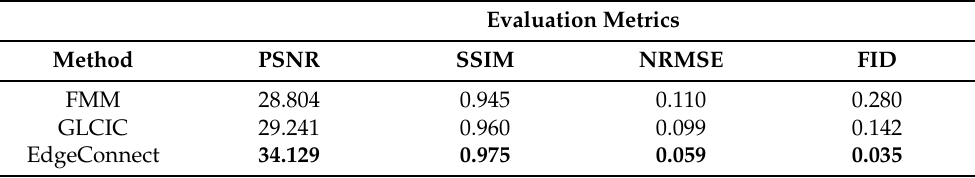
Table 2. Evaluation metrics of the traditional method and our